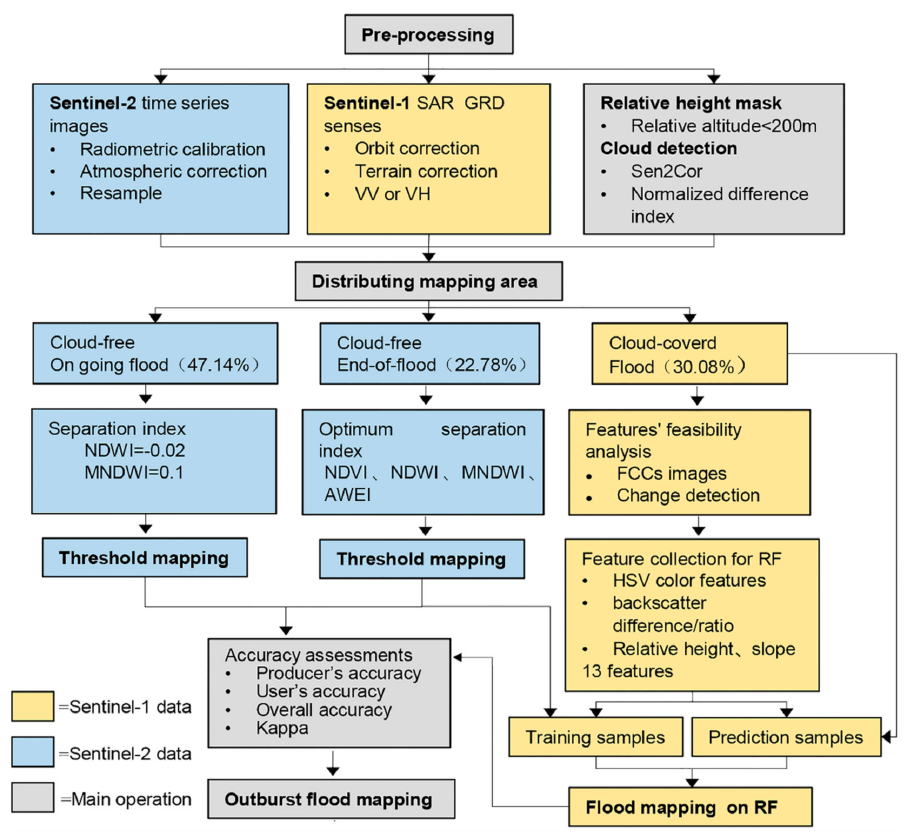
Figure 4. The workflow of the proposed method for the outburst floods.